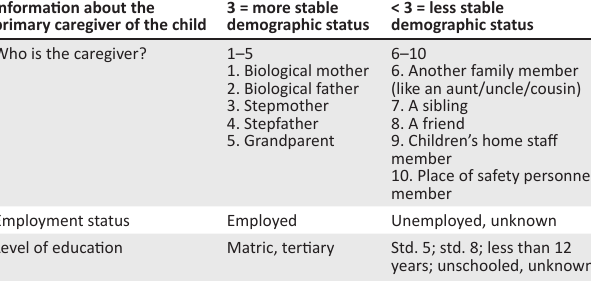
3 = more stable < 3 = less stable demographic status demographic status